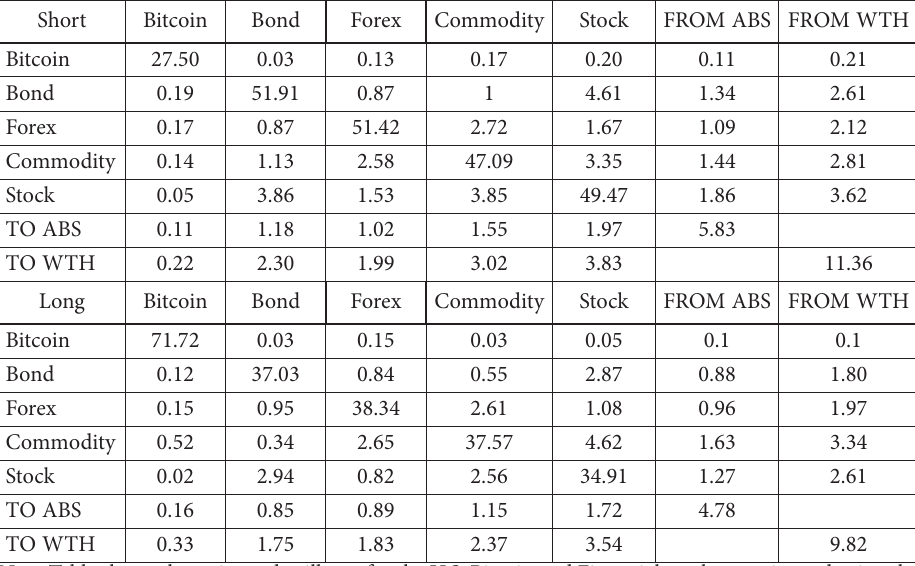
Table 4. Frequency domain spillover table for U.S. bitcoin and financial markets